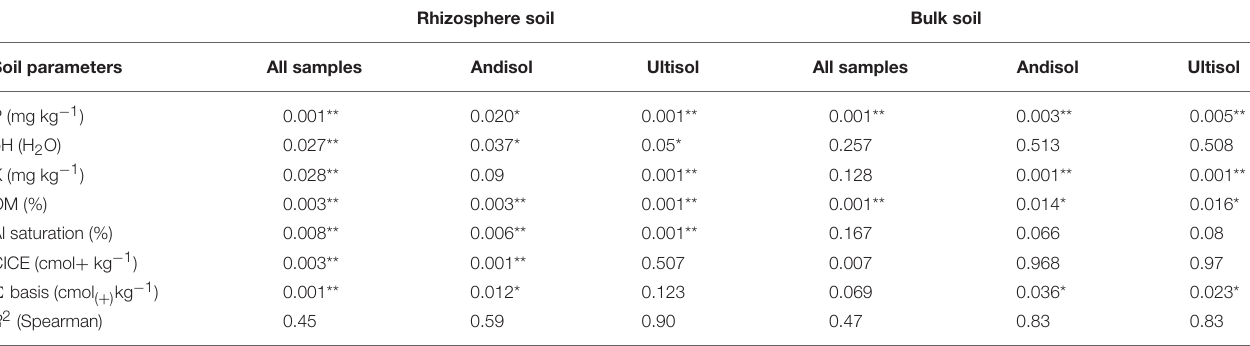
TABLE 3 | R 2 values and significance level for NMDS ordination and environmental